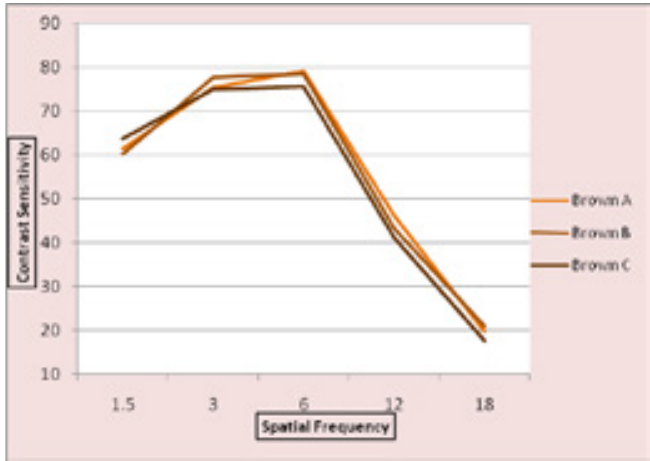
Figure 3: Contrast sensitivity functions for the varying densities (A, B and C) of the brown tint